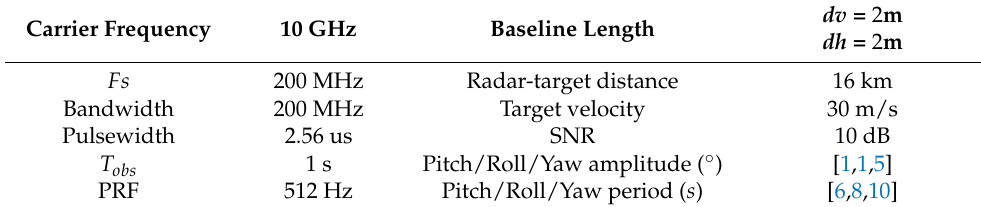
Table 2. Simulation Parameters—Ship.